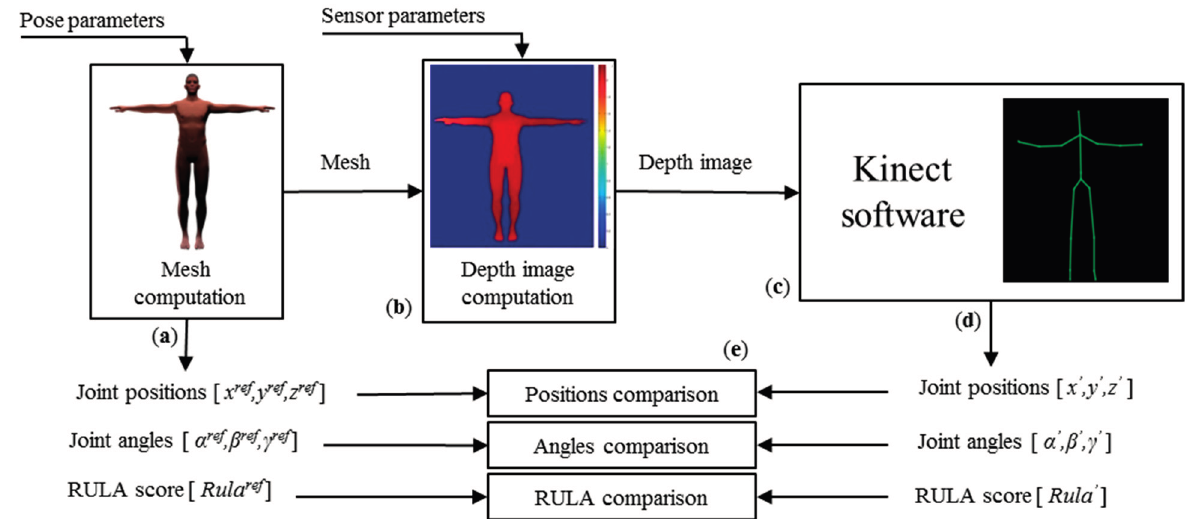
Figure 1. Overall method pipeline. ( a ) 3D meshes in specific poses, joint position values of reference (x ref , y ref , z ref in meters), computed joint angle values of reference ( α ref , β ref , γ ref in degrees), and computed RULA score (Rula ref ); ( b ) Depth images of the mesh in specific sensor positions; ( c ) Analysis of the depth images with the Kinect software for joint localization [15]; ( d ) Estimated joint position values (x’, y’, z’ in meters), computed estimated joint angle values ( α ’, β ’, γ ’ in degrees), and computed estimated RULA score (Rula’); ( e ) Measure error between values of reference and estimated